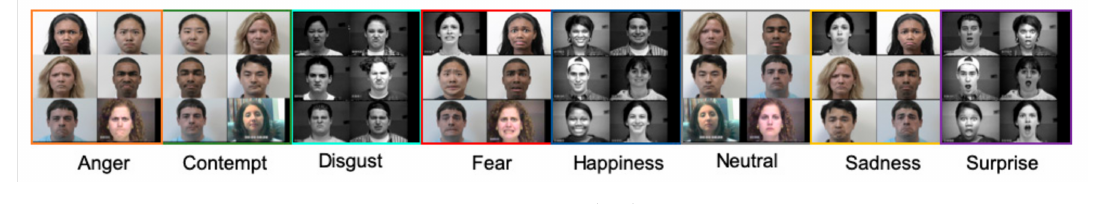
Figure 10. CK + database. Table 7. Recognition results of di ff erent architectures with Adagrad optimization method.